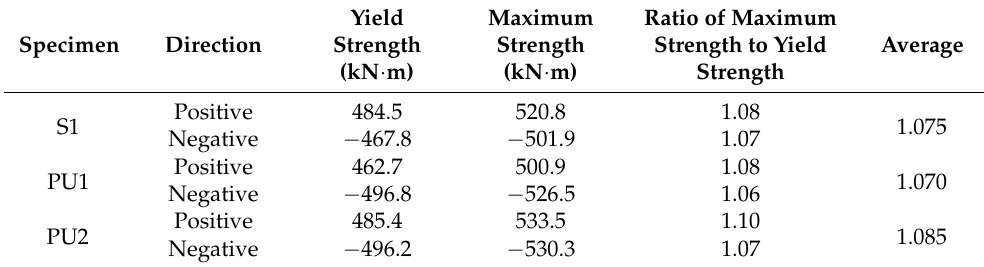
Table 4. Comparison of the strength of specimens.